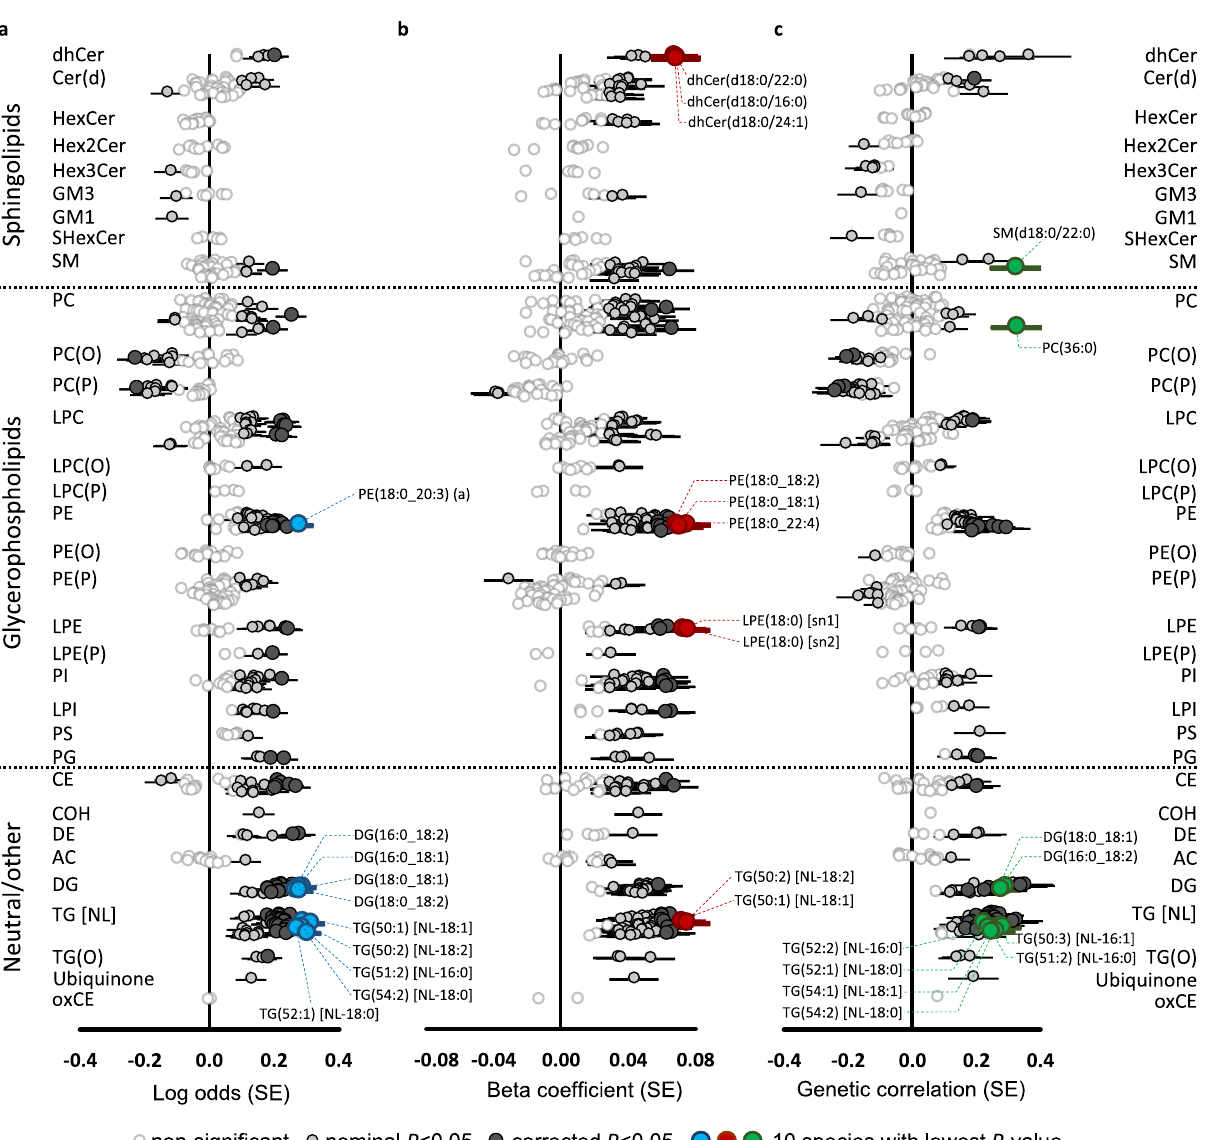
Fig. 5 Genetic and phenotypic associations of the lipidome with coronary artery disease. Forest plots of lipid-coronary artery disease; circles represent effect sizes and horizontal bars represent ±standard errors. a Phenotypic associations (logistic regression; two-sided) between lipid species and incident coronary artery disease in the BHS cohort (551 cases and 3703 controls), adjusted for age, sex, and the fi rst 10 genomic principal components. b Association of lipid species with polygenic risk for coronary artery disease. Individuals in the discovery cohort ( n = 4492) were assessed for risk using the metaGRS polygenic score, consisting of ∼ 1.7 million genetic variants. Linear regressions (two-sided) were performed to test the association between an individual ’ s polygenic score and lipid species concentrations, adjusting for age, sex, and the 10 fi rst principal components. c Genetic correlations of lipid species ( n = 4492) against coronary artery disease (meta-analysis of CARDIoGRAMplusC4D and UK Biobank; 122,733 cases and 424,528 controls), performed with Linkage Disequilibrium Score Regression (LDSC; v1.0.1). Nominally signi fi cant and Benjamini – Hochberg corrected signi fi cance is indicated by light- and dark-grey circles, respectively. The 10 most signi fi cant lipid species are highlighted in blue, red, or